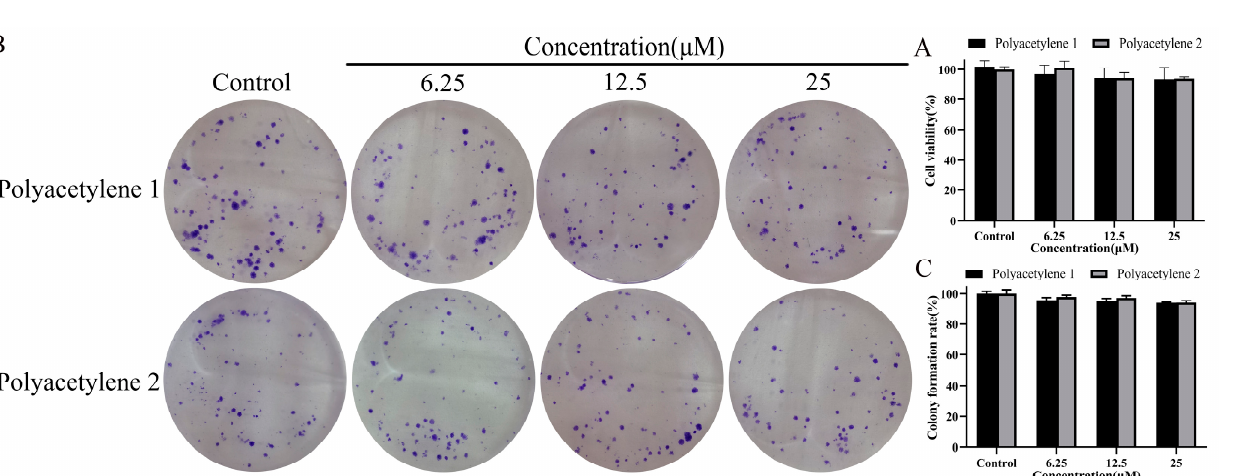
Table 1. The cytotoxic activity of polyacetylene 1 against tumor cell lines and normal cell lines. Cell Line